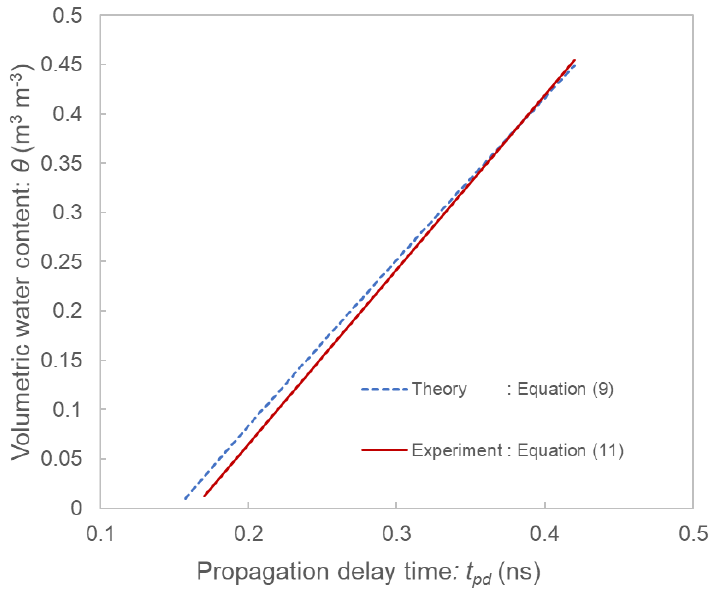
Figure 7. Comparison of the theoretical calibration equation from Equation (9) (blue line) and experimental calibration according to Equation (11) (red line) of the SFDT sensor using Toyoura sand.